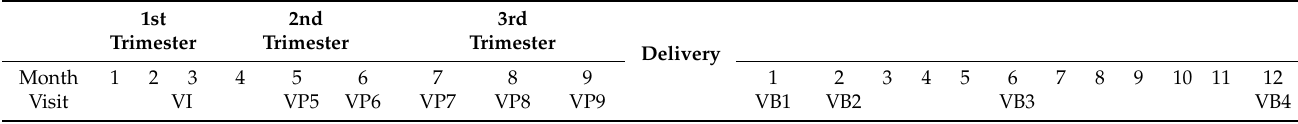
Table 1. Synopsis of study design. Study timeline for each